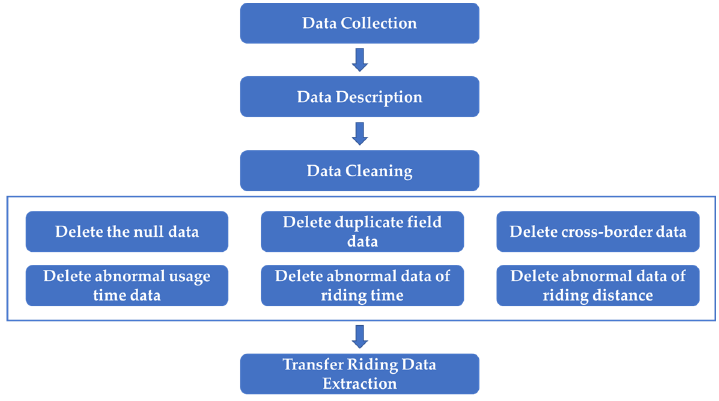
Figure 1. Diagram of data collection